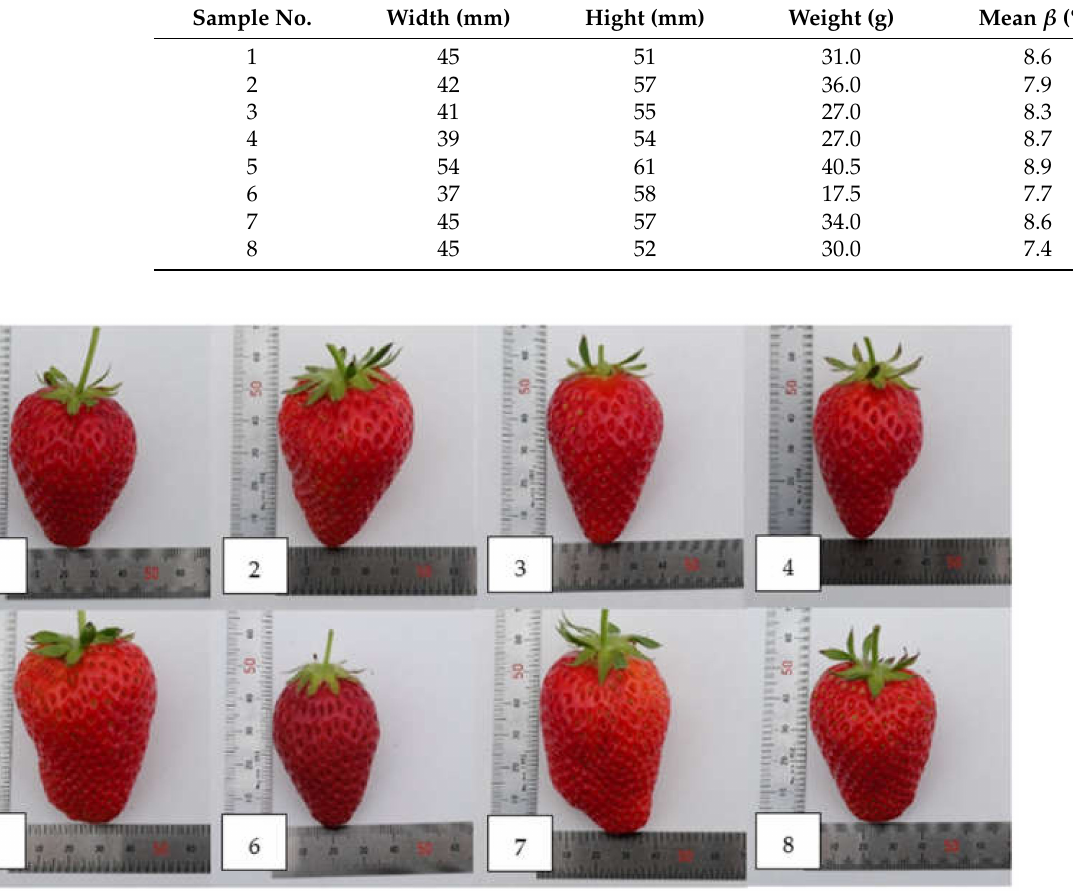
Figure 13. Strawberry fruits harvested on 5 April